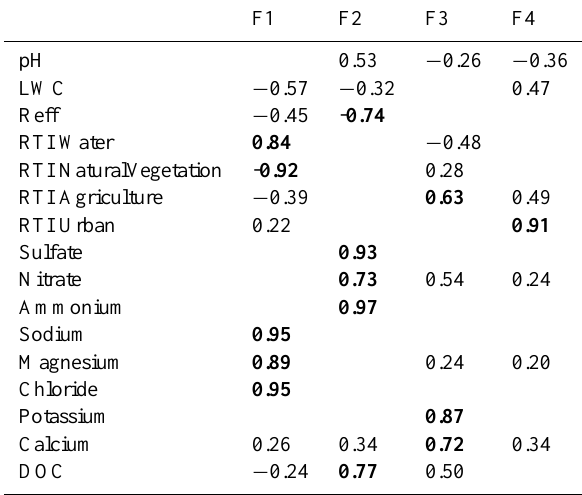
Table 4. Factor loadings of four principal components after Varimax rotation. Loadings with absolute values <0.2 are regarded insignif- icant and omitted, while those >0.6 are regarded highly significant and printed